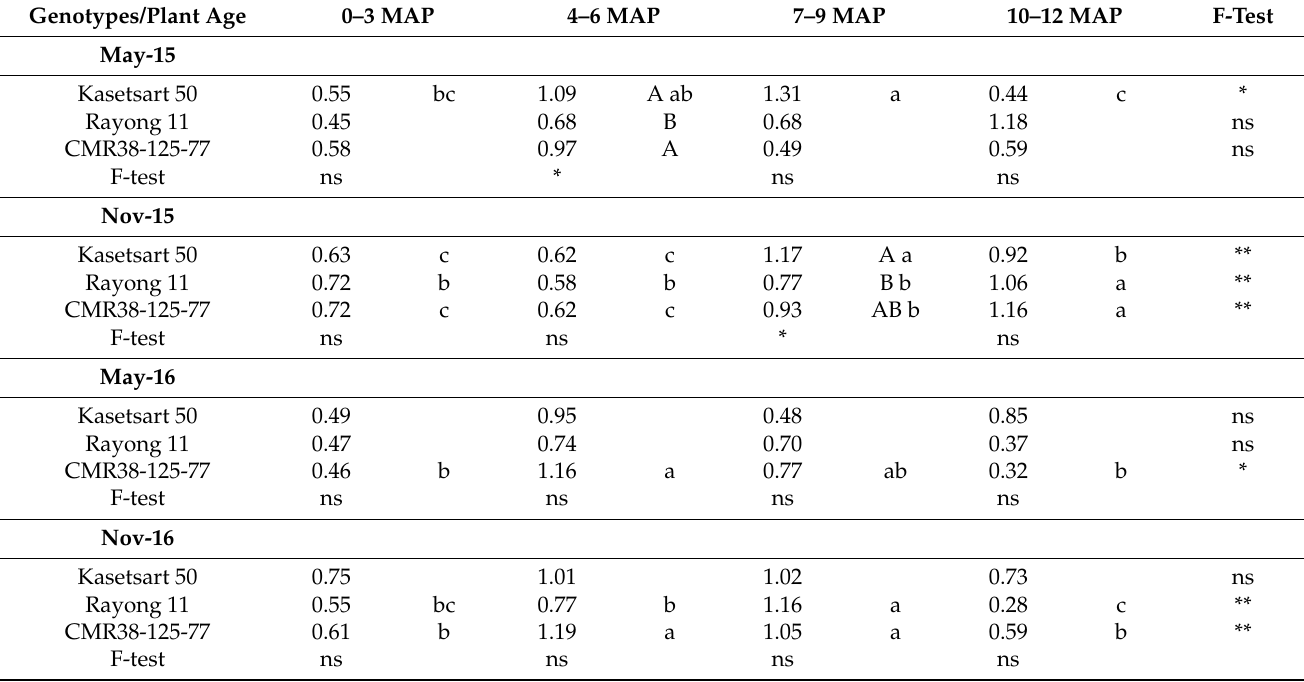
Table 2. Radiation use efficiency (g MJ − 1 ) for biomass of 3 cassava genotypes in different growth stages for May and November plants for 2